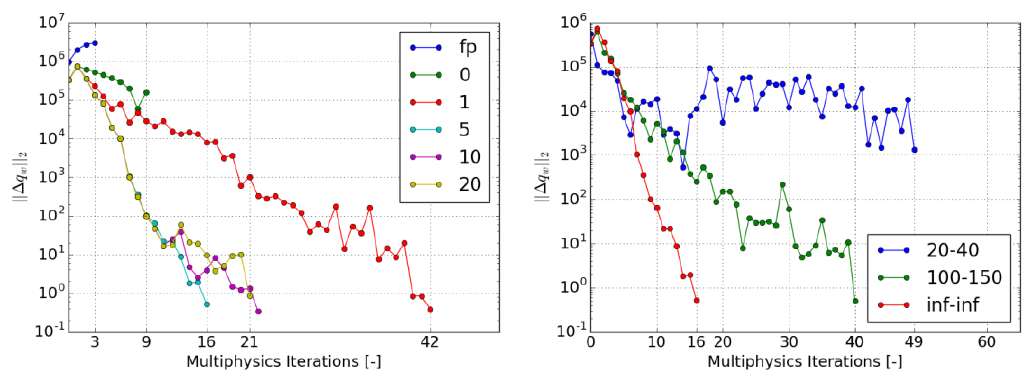
Figure 5: Convergence of (cid:11) (cid:5) . On the left, it is reported for the Anderson algorithm for several values of the V parameter and for the fixed-point iterations (fp), both with no limits on the iteration numbers. On the right, same algorithm with V =5 and different limits on the number of